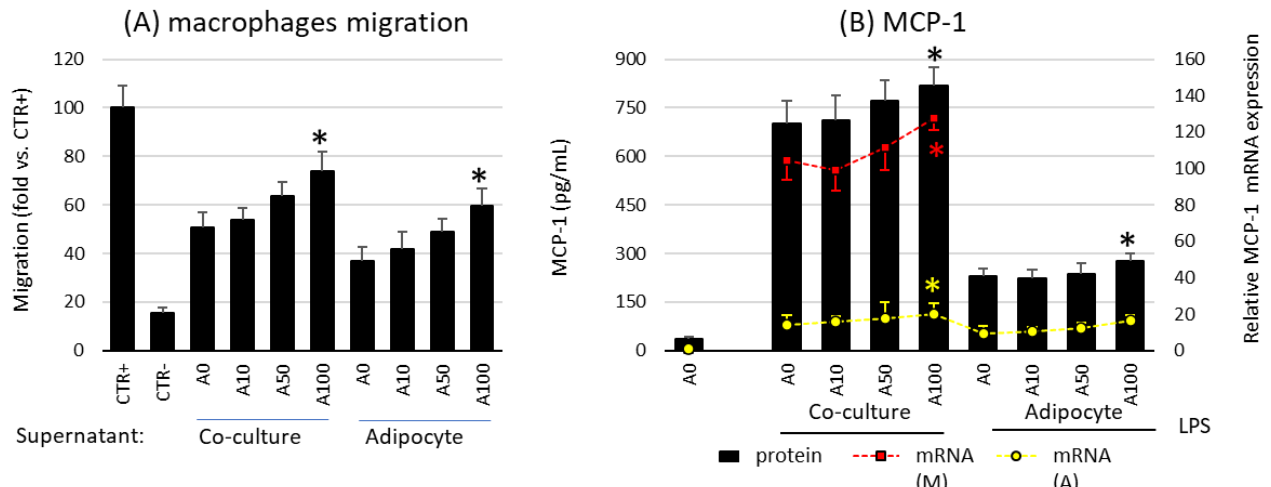
Figure 5. Effects of asprosin on ( A ) the migration of RAW 264.7 macrophages to the conditioned medium collected from co-culture or adipocytes cultured in the presence of various asprosin con- centrations (0, 10, 50, or 100 nM) for 24 h (after 21 days of differentiation). Normal medium was used as a negative control (CTR-); N-formylmethionyl-leucyl-phenylalanine (fMLP) was used as a positive control (CTR+). ( B ) The effects of asprosin on lipopolysaccharide (LPS)-induced monocyte chemotactic protein 1 (MCP-1) mRNA expression and release by adipocyte–macrophage cocultures or adipocytes. The results are expressed as mean + standard deviation (SD) from five independent experiments. Statistical significance ( p < 0.05) was determined by the Duncan t -test. The asterisk (*) above the bar denotes statistically significant differences in migration, protein or mRNA levels, calculated relative to the A0 (A) or A0 + LPS (100 ng/mL) control group. Cells: (M) macrophages; (A) adipocytes.